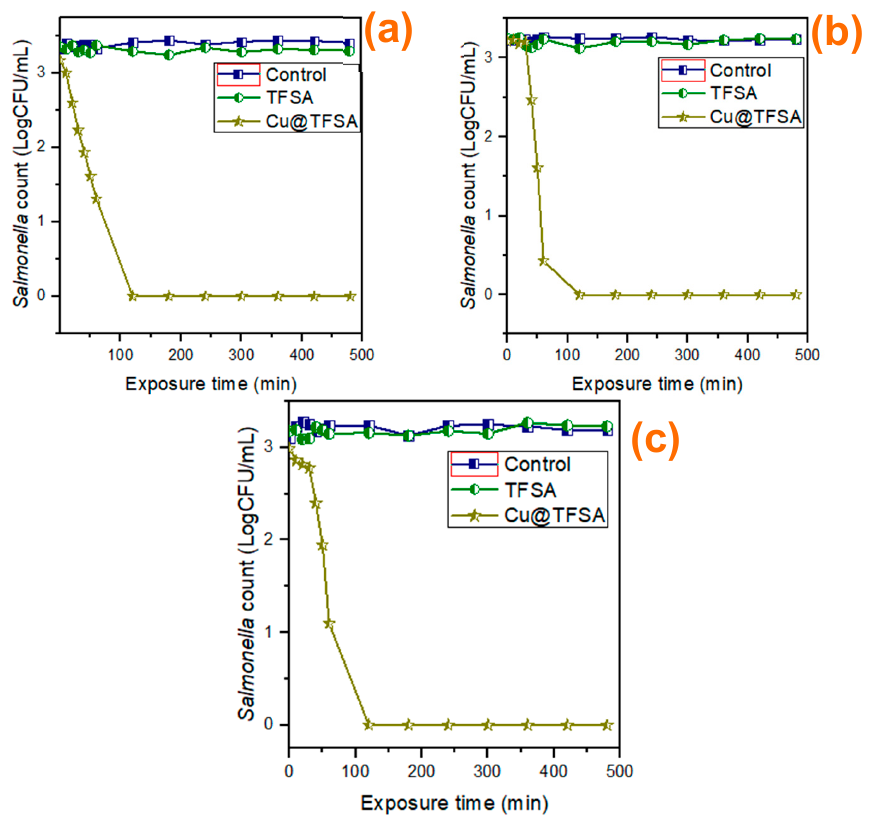
Figure 7. ( a ) The effect of exposure time on Salmonella by Cu@TFSA in synthetic water; ( b ) the effect of exposure time on Salmonella by Cu@TFSA in groundwater, and ( c ) the effect of exposure time on Salmonella by Cu@TFSA in river water.